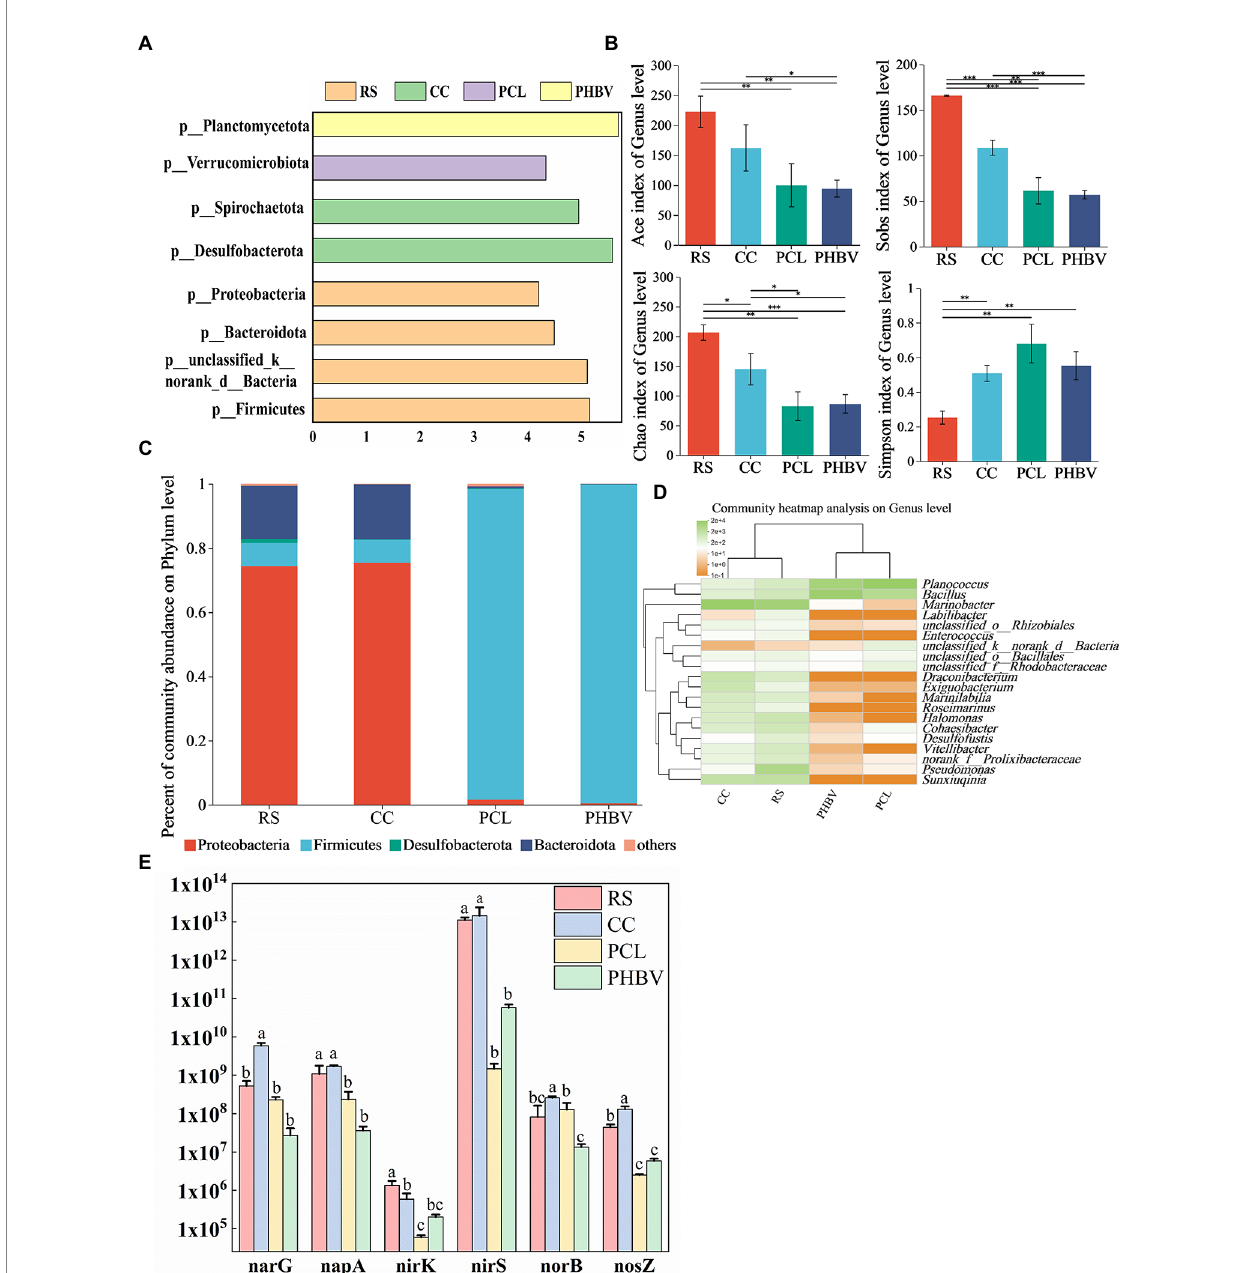
FIGURE 6 Composition and structure of microbial and abundance of nitrogen-functional genes. (A) The linear discriminant analysis (LDA) analysis at phylum level; (B) Relative abundance at phylum level; (C) Alpha diversity index of microbial community at genus level; (D) Clustering heat maps at the level of the first 20 genera; (E) Differences in the abundance of the same gene with different carbon